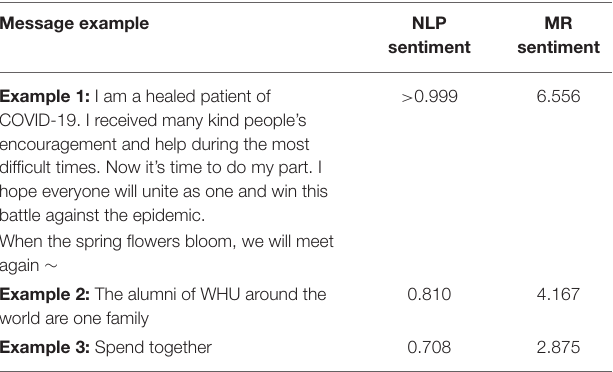
TABLE 1 | Message examples in the